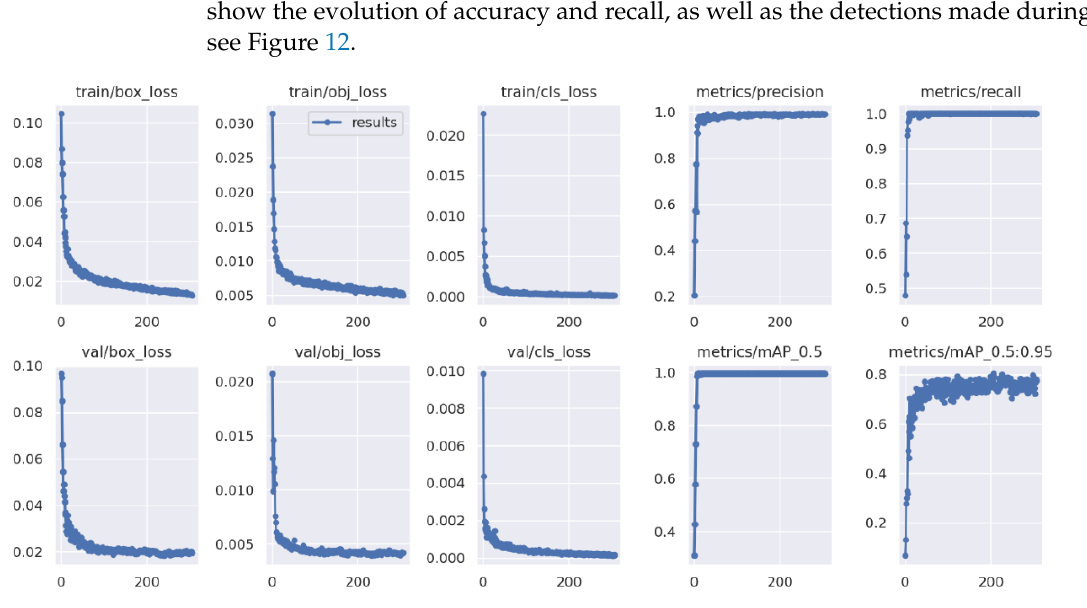
Figure 13. Floating mine detection model YOLOv5. The procedure is similar for anchored mines, the results are shown in Figures 14 and 15: Figure 14. YOLOv5 network training parameters of naval mines for submarines.